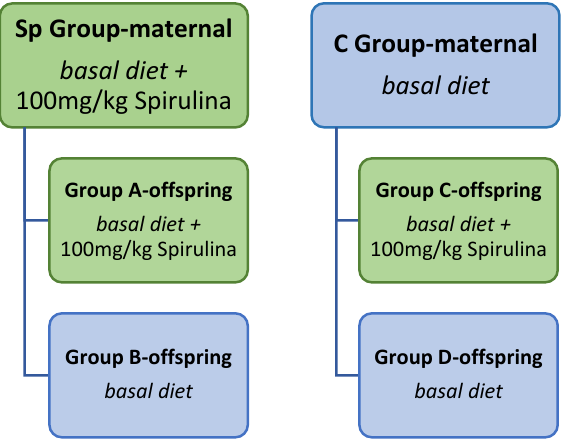
Figure 1. Experimental layout.